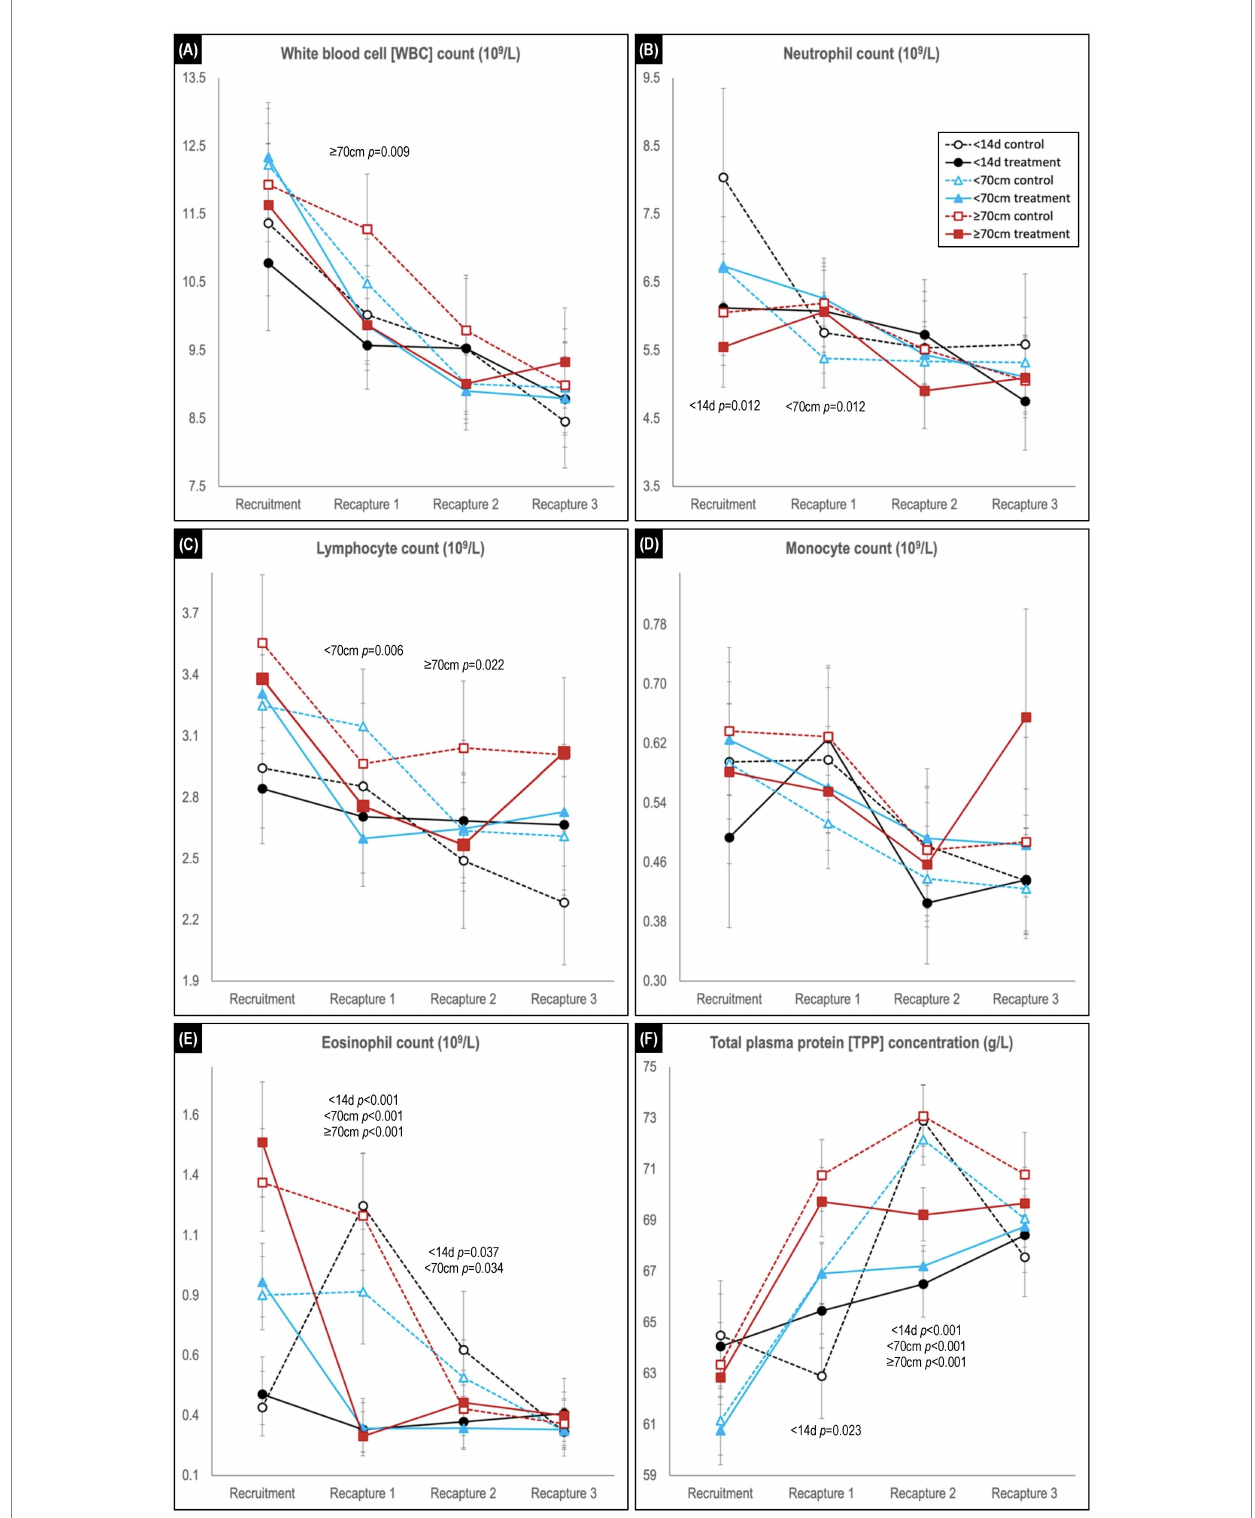
FIGURE 5 Comparison of predicted mean or median* values (and 95% confidence intervals) for (A) white blood cell, (B) neutrophil, (C) lymphocyte, (D) monocyte, and (E) eosinophil counts, and for (F) total plasma protein concentration in hookworm treated and control groups of Australian sea lion pups. Results are stratified by pup recruitment age (size) cohorts – <14 d prepatent, <70 cm standard length, and ≥ 70 cm standard length. Significant between treatment group differences within any of the three age cohorts are listed adjacent to the respective capture. Differences between treatment groups within the same age cohort quantify the impact of hookworm infection, which is superimposed on temporal changes attributable to hematological ontogenesis in maturing pups. The median interval (and range) for the recruitment-to-recapture 1, recapture 1-to- recapture 2, and recapture 2-to-recapture 3 periods for the combined cohorts were 31 d (15–111d), 31 d (20–99 d), and 33 d (20–99 d), respectively. *Transformed model estimates and their associated 95% CI boundaries were back transformed prior to reporting and should be interpreted as medians rather than means (refer to Supplementary Table S2 for specific detail values of transformed